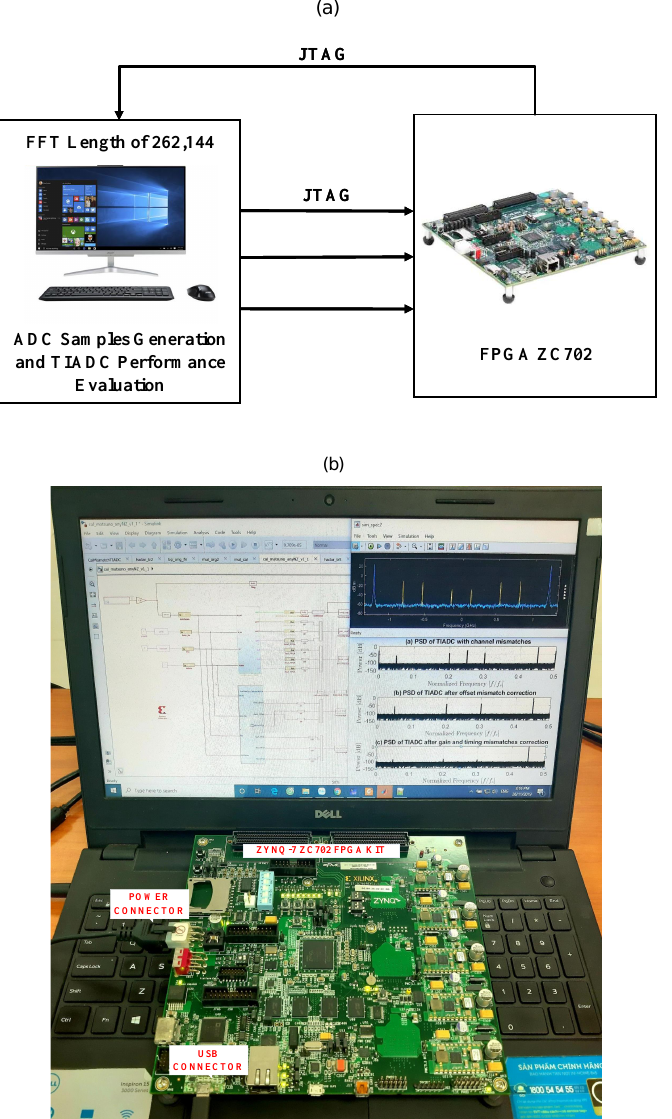
Figure 9. Experimental setup and laboratory measurement for the FPGA based implementation: ( a ) Experimental setup model, ( b ) FPGA based measurement in the